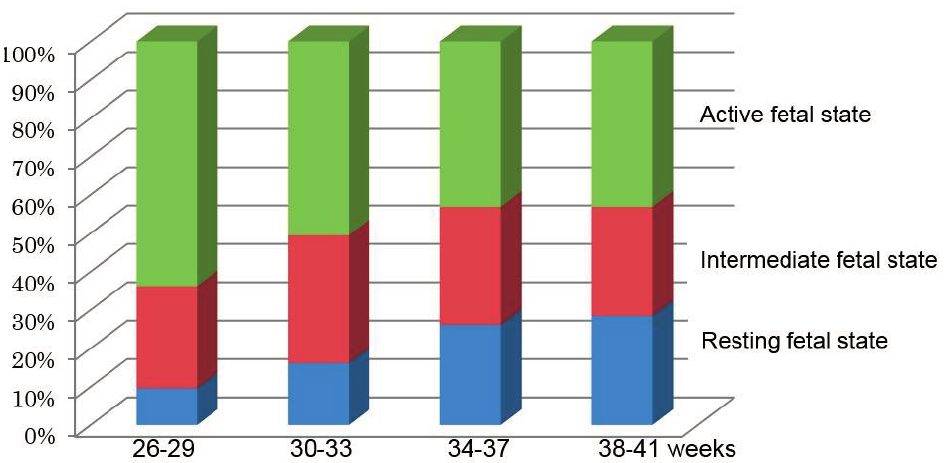
Figure 4. Fetal behavioral states obtained by computer analysis at four pregnancy